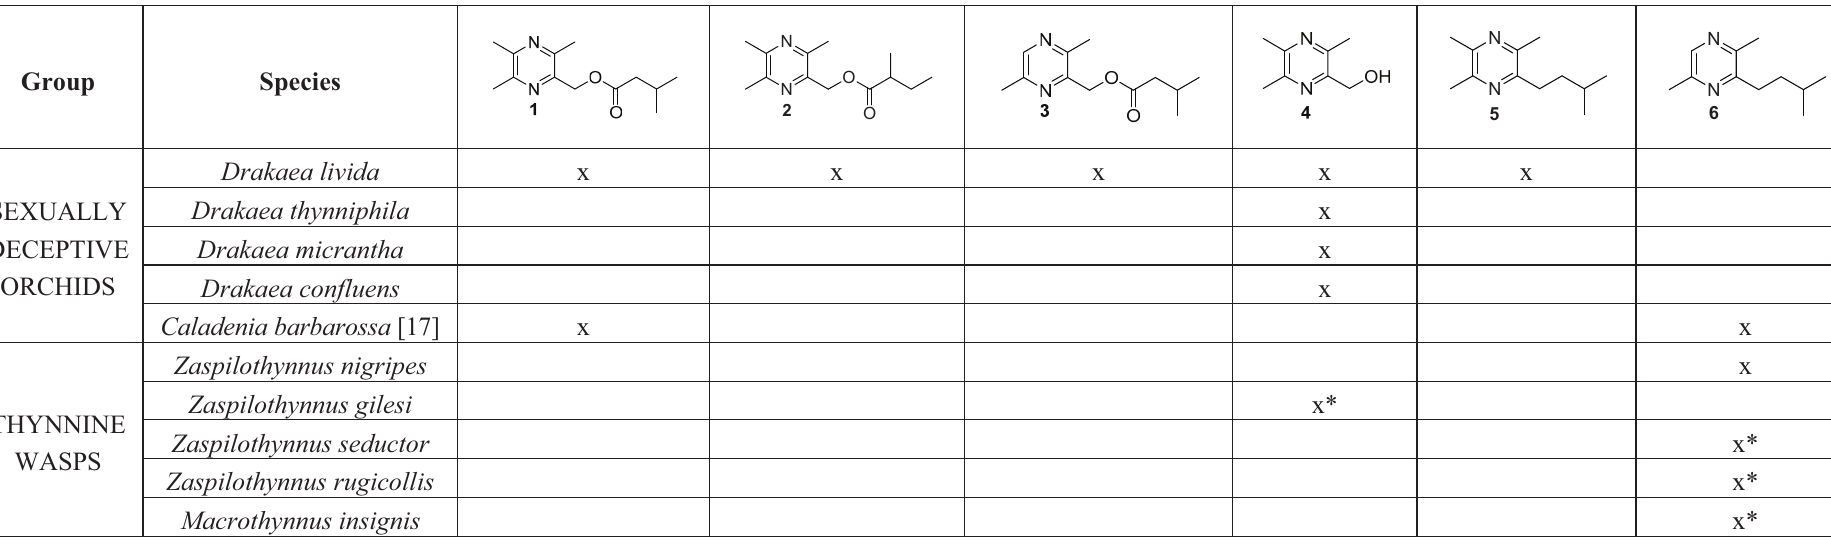
Table 1. GC-EAD active pyrazines against male Catocheilus wasps; structures and presence in Western Australian sexually deceptive orchids and female thynnine